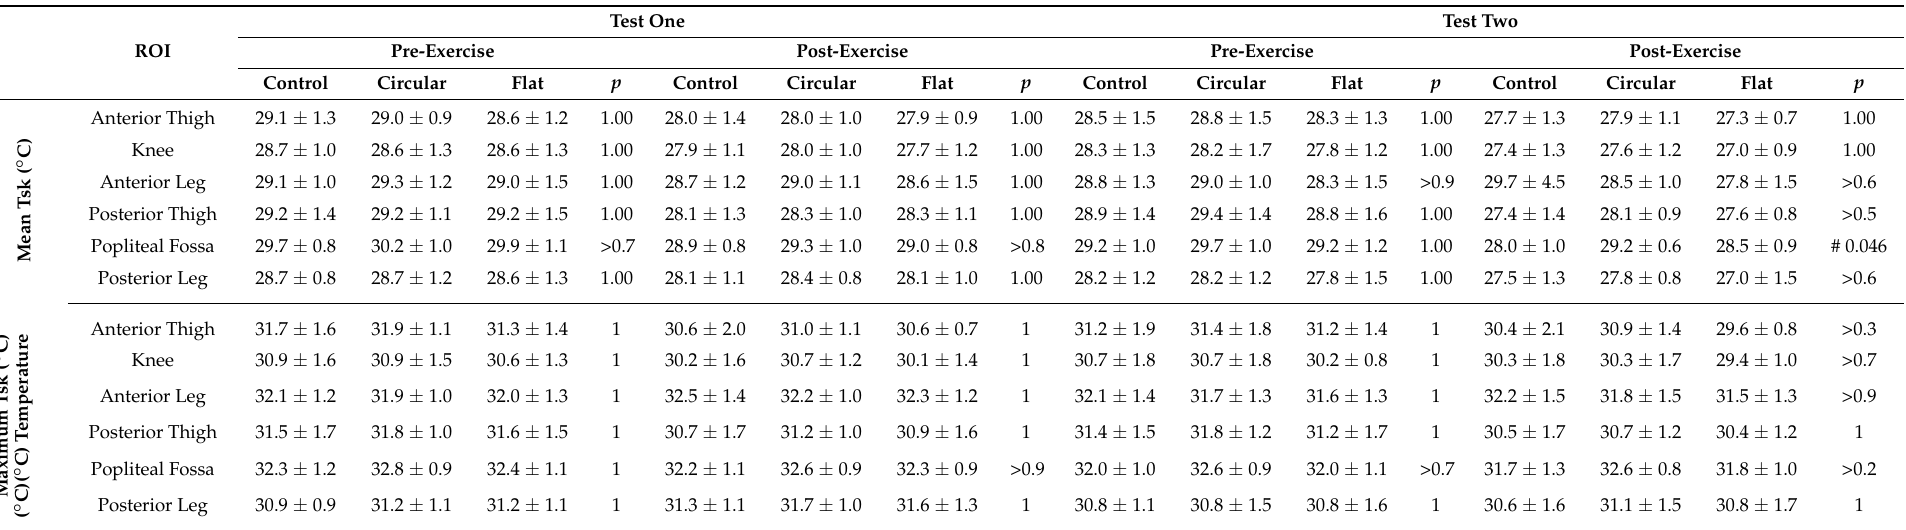
Table 2. Mean and maximum skin temperature values of the first and second